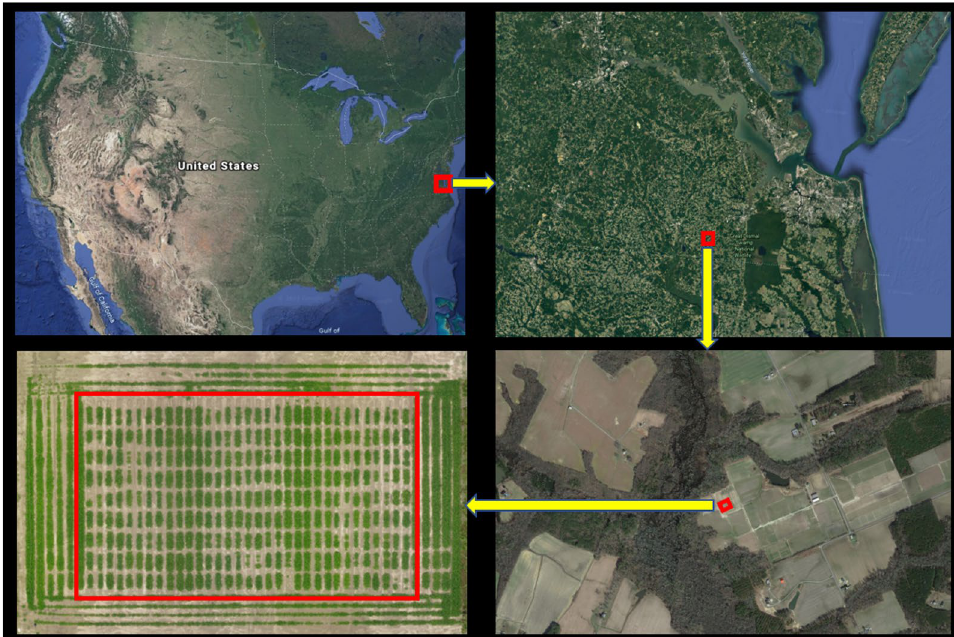
Figure 1. Location of the experimental field in 2017. Each image shows the geographic location of the study using red box, which is then zoomed out to the next image. The red box in the last image is the actual esperimental field with peanut plots. The physical maps are taken from google earth (https:// earth. google. com/ web) and the aerial image of the plots was created using Pix4Dmapper Version 4.2.26 software (Prilly, Switzerland).